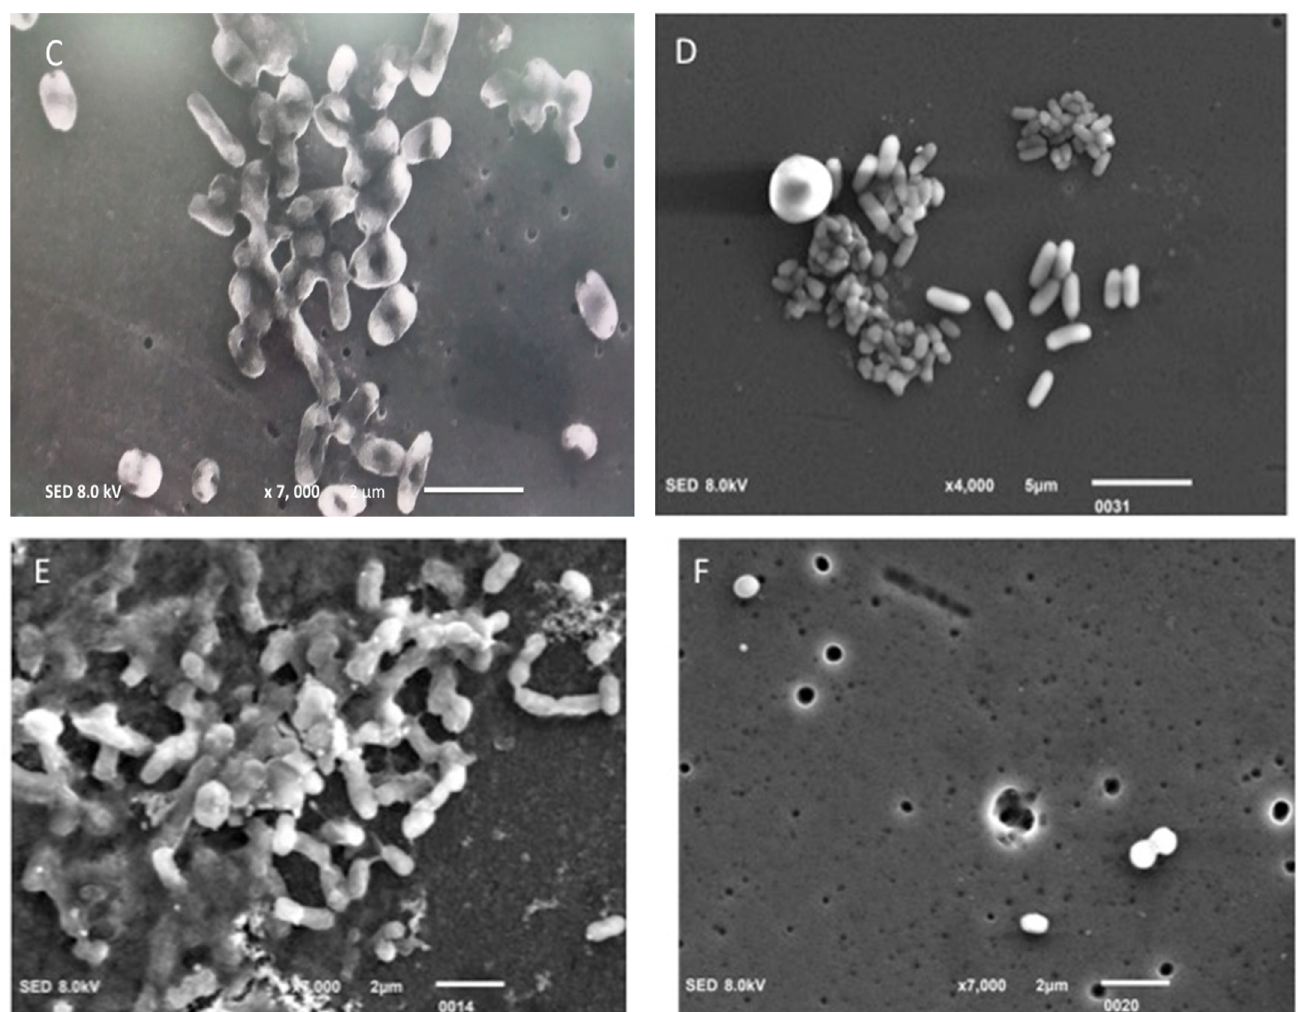
Figure 5. ( A ) Micrograph of biofilm positive consortia harboring cocci and bacilli. ( B ) Observe the attachment of mixture of live cells E. coli (rods) S. aureus and S. mutans (Cocci) on PMMA prior to disinfection. ( C ) Dead cells attached to the surface of acrylic slide, disinfected by exposure to MW at 450 W for 1 min (24 h). ( D ) Dead cells attached to the PMMA surface, disinfected by exposure to MW at 450 W for 1 min (48 h). ( E ) Dead cells on PMMA surface disinfected by MW with DC for 2 min (36 h). ( F ) PMMA surface disinfected with DW with DC for 5 min (24 h).